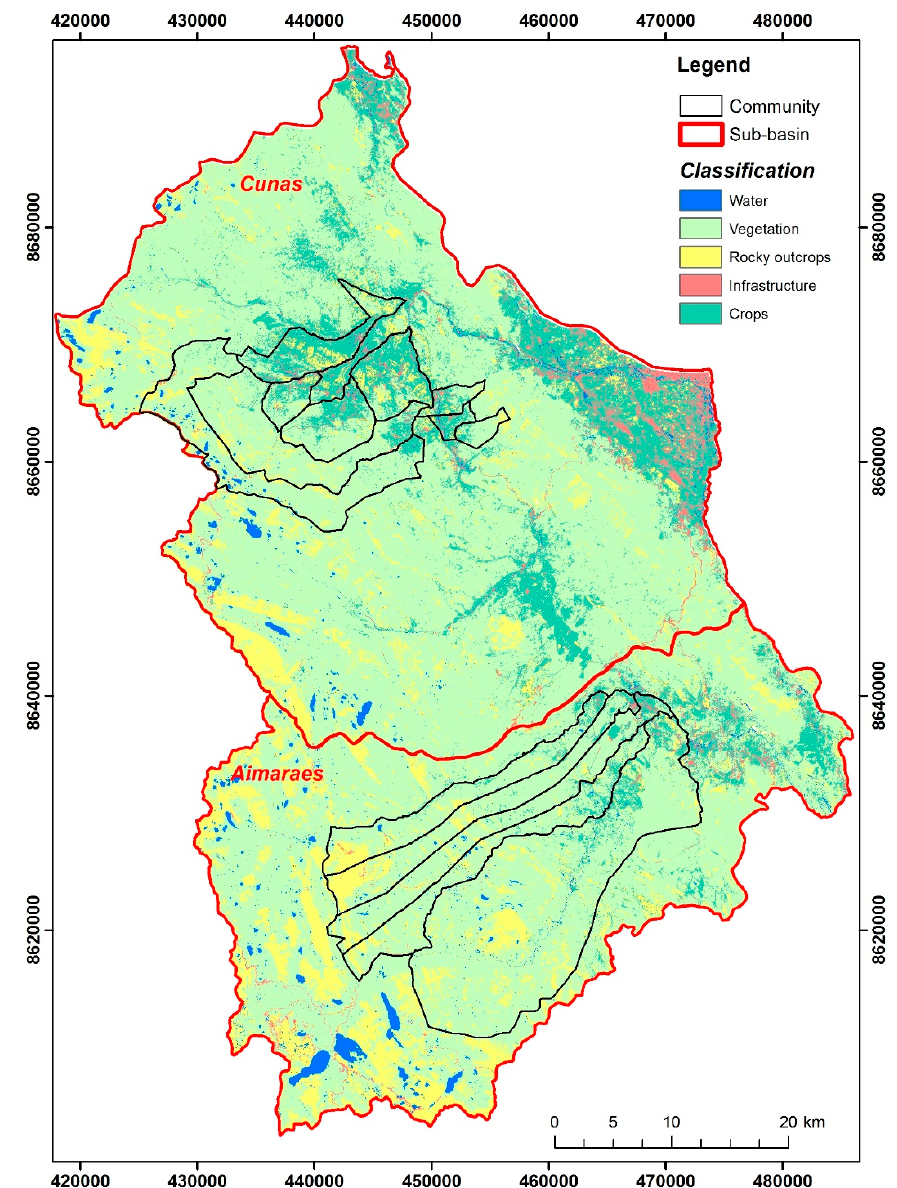
Figure 4. Land-cover classification based on the reclassification of the maximum likelihood classification method.